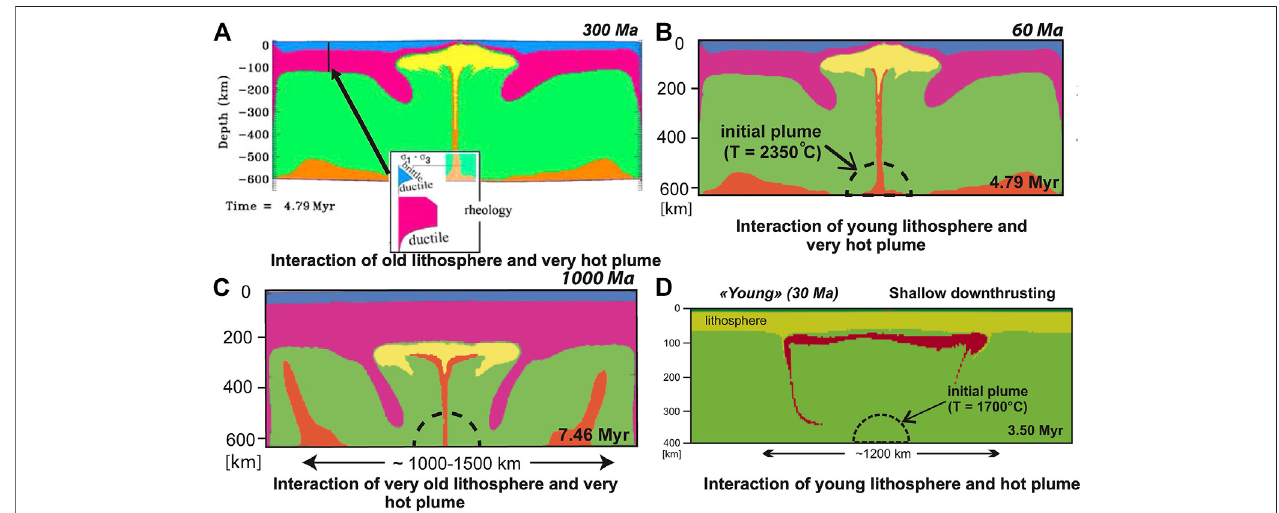
FIGURE 2 | Plume-continental lithosphere interaction. (A) Numerical modeling results of interaction of an extremely hot plume with a homogeneous, strong 300 Myr continental plate, showing intrusion of plume in continental crust and decoupling of mantle lithosphere from the crust, leading to sinking of continental lithospheric mantle (adapted from Burov and Cloetingh, 2010). (B,C) Numerical modeling results of an impinging very hot plume head with (B) young and (C) old continental lithosphere which leads to sinking of lithospheric mantle and underthrusting of lower parts of the lithospheric mantle, respectively. (D) Numerical modeling results of interaction of a plume head (with a more realistic temperature) with young lithosphere which causes foundering of the lowermost lithospheric mantle (Panels (B – D) are adapted from Cloetingh et al., 2021).